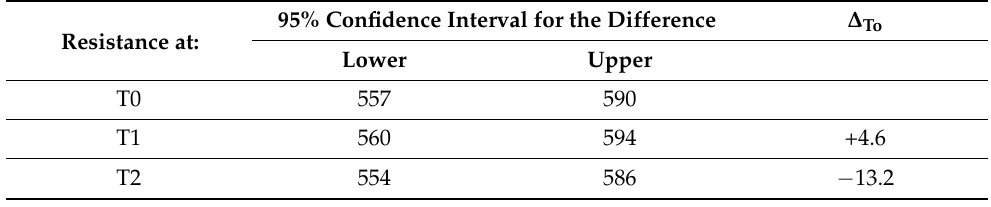
( Ω ) is Table 2. Cyclotron— lower and upper values of resistance (Ω). The delta of average resistance values (Ω) is included.